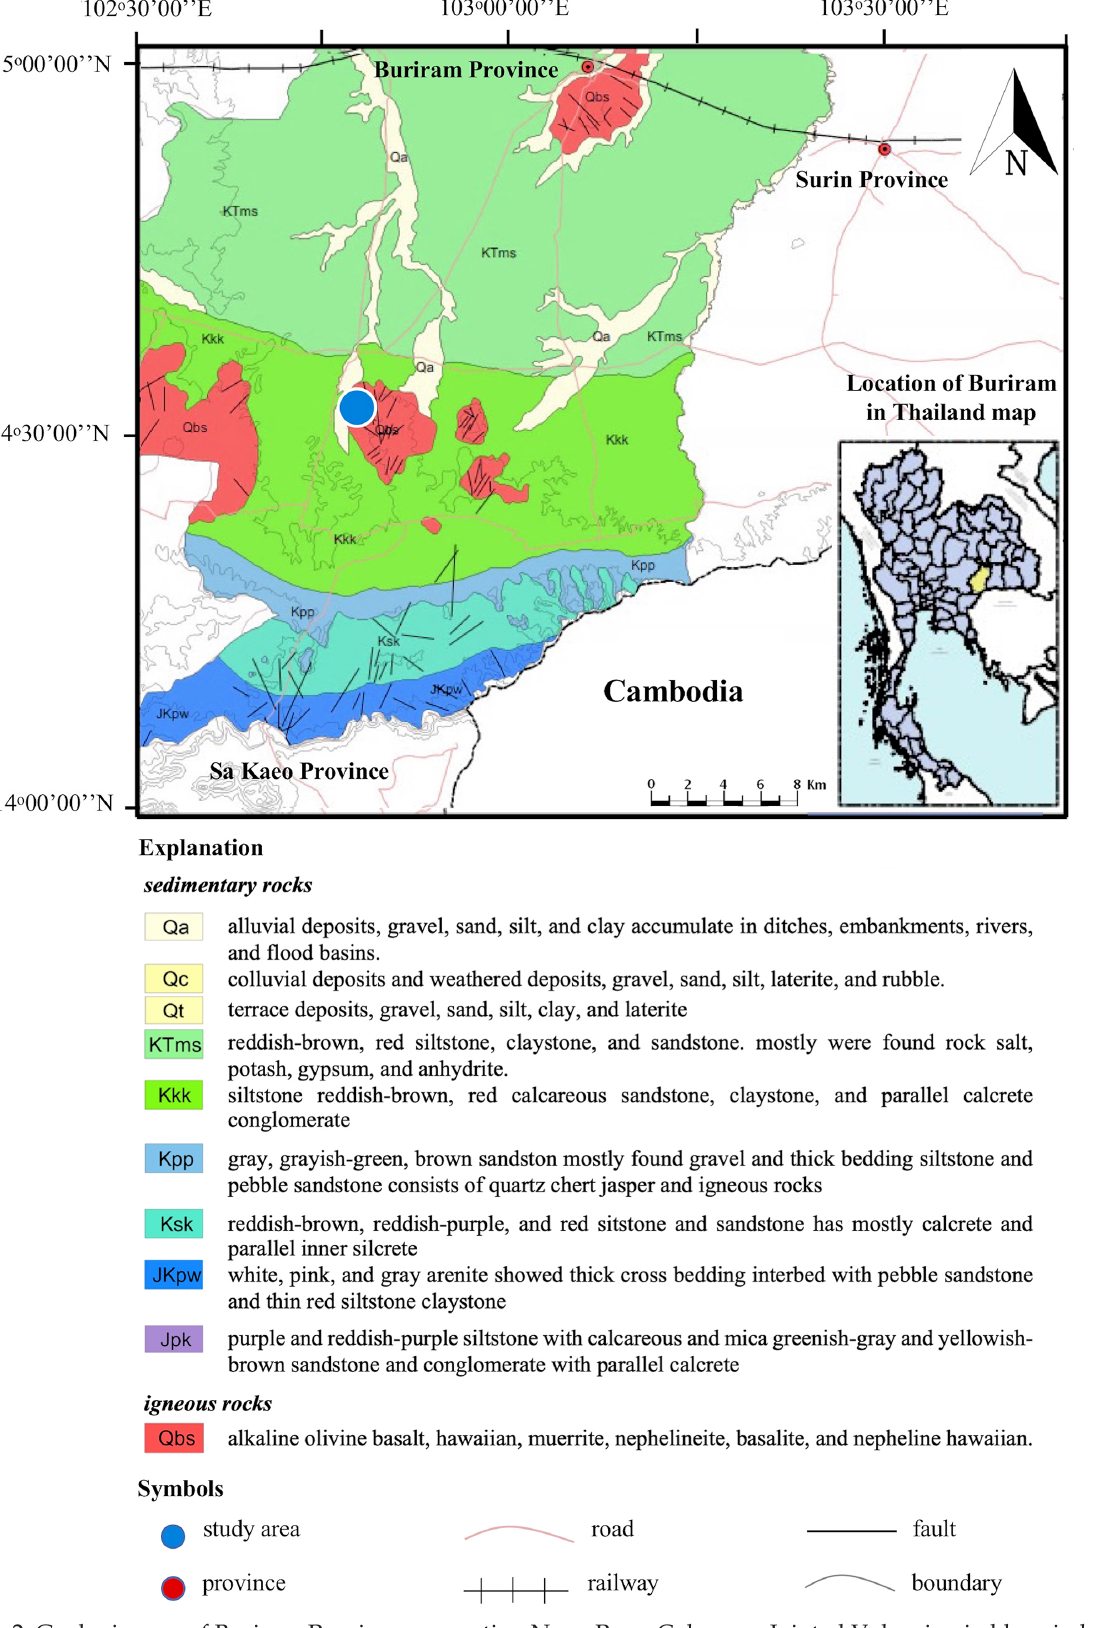
Fig. 2. Geologic map of Buriram Province, presenting Nang Rong Columnar Jointed Volcanics in blue circle (DMR 2001,